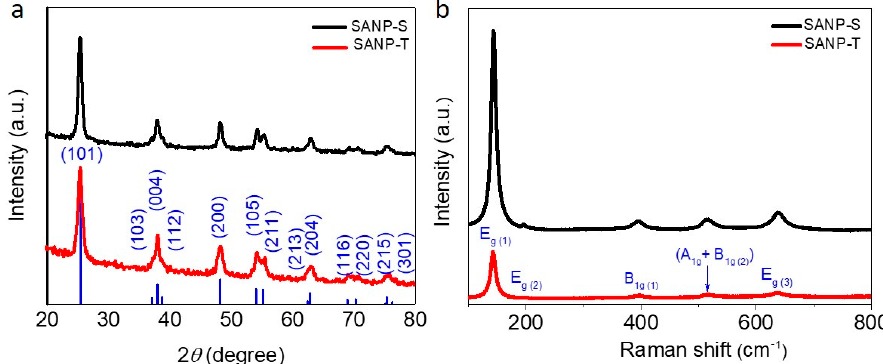
( b ) Raman spectra of SANP-S and SANP-T films.